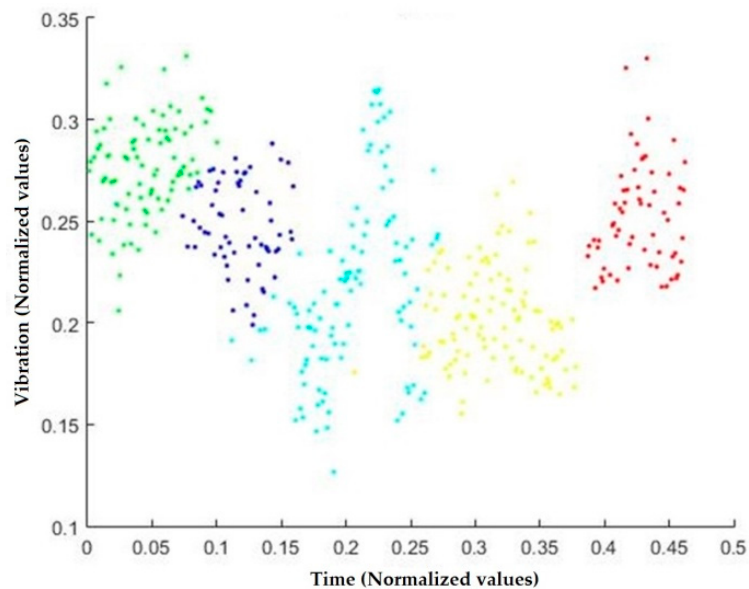
Figure 9. VNS-clustering illustrative example.